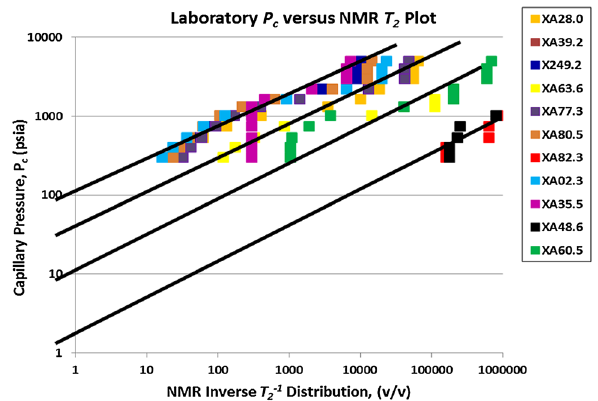
Fig. 8 Mercury injection capillary pressure curves versus inverse NMR T 2 distribution for samples dataset from indicating nonlinearity in relationship